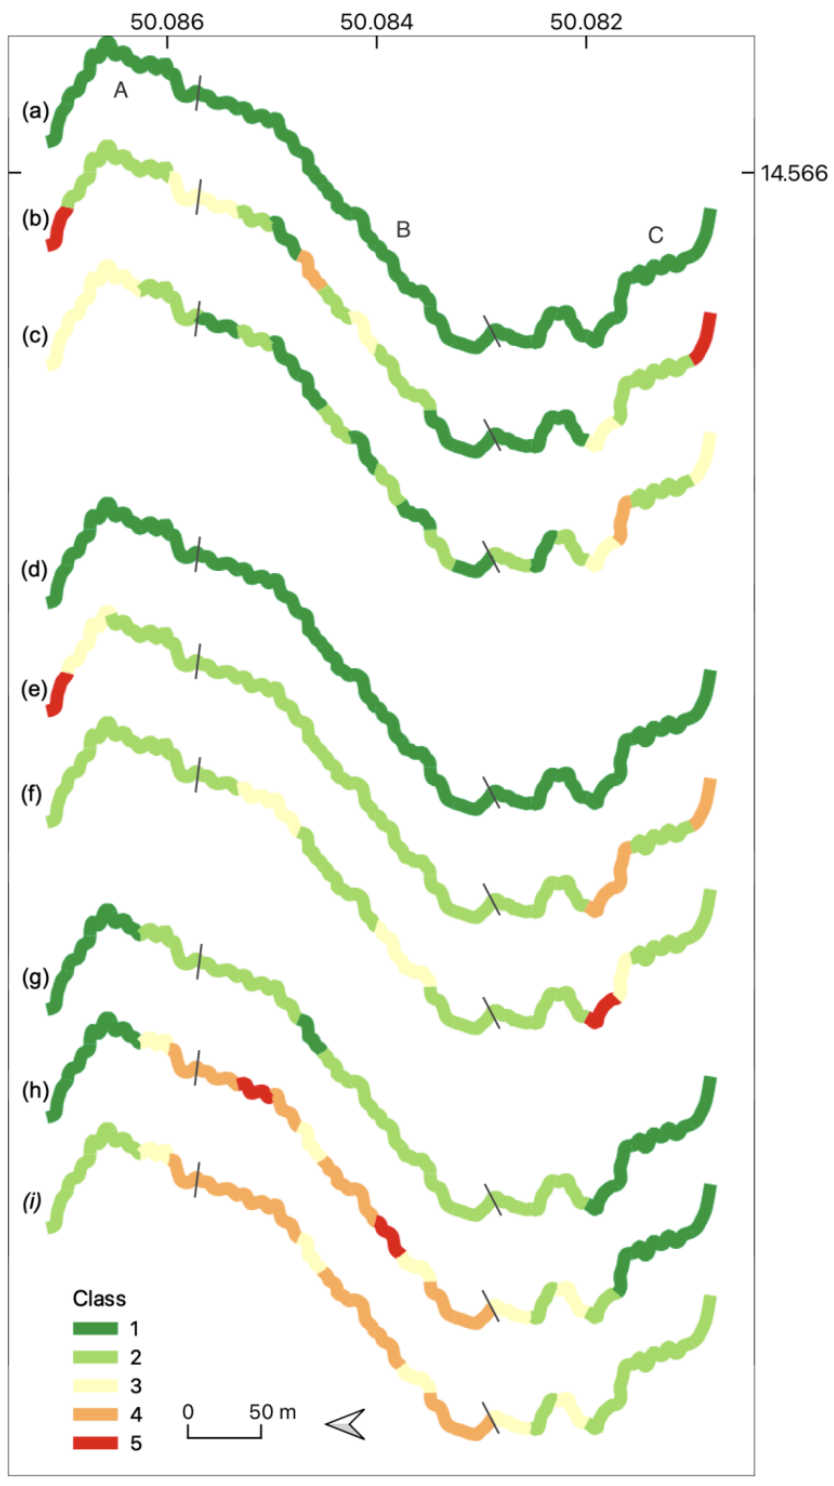
Figure A2. Assessment of restoration indicators in Hostavický brook (HOS). ( a ) Channel modifications, ( b ) Channel stability, ( c ) Bed variability, ( d ) Flow continuity, ( e ) Floodplain connectivity, ( f ) Water quality, ( g ) Vegetation coherence, ( h ) Riparian shading, and ( i ) Woody debris.